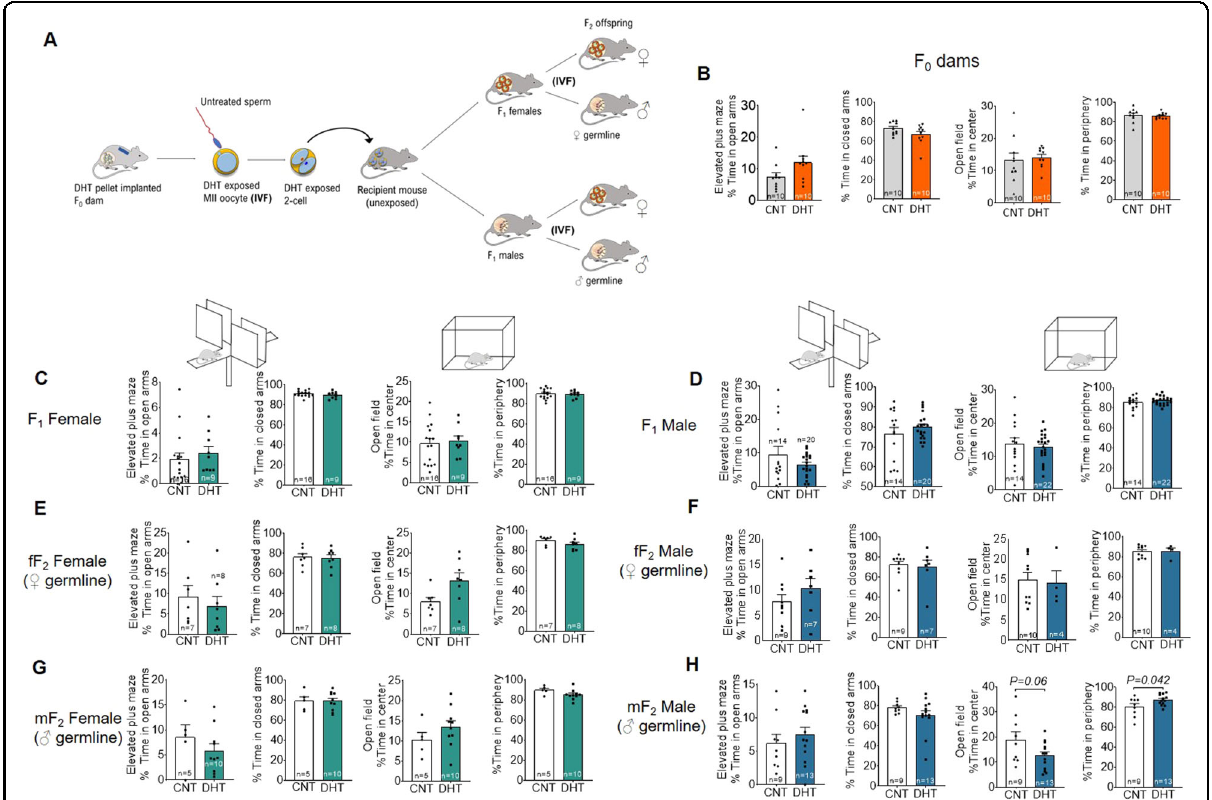
Fig. 5 Germ cells versus in utero environment in the transmission of anxiety like phenotype in offspring. A Schematic illustration showing prepubertal mouse model and generation of F 1 and F 2 offspring by using IVF. B – D Time spent in the open arms in the elevated plus maze (EPM); time spent in the closed arms of the EPM; time spent in the center of the open fi led (OF); time spent in the periphery of the OF. Data were analyzed with Student ’ s t -test. All data are presented as mean ± s.e.m. CNT control, DHT